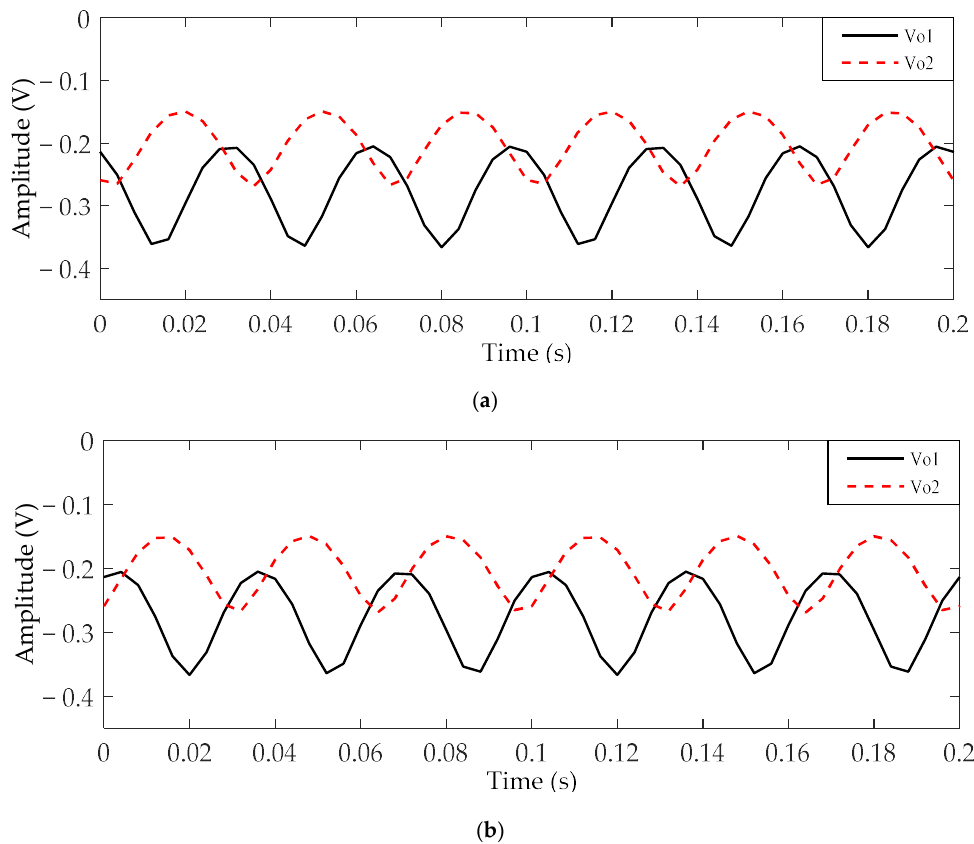
Figure 7. The ideal output signals of V o1 and V o2 for d = 7 cm: ( a ) signals V o1 and V o2 obtained when the rotor rotates clockwise; ( b ) signals V o1 and V o2 obtained when the rotor rotates anticlockwise.